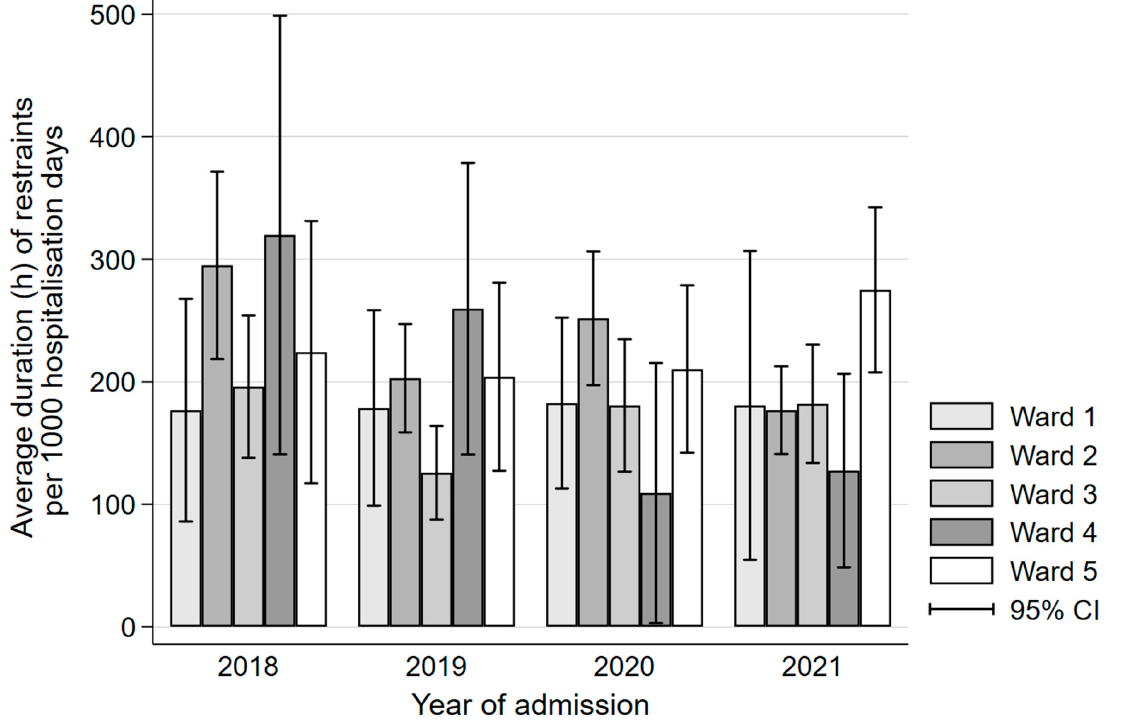
Figure 4. Bar chart of average duration in hours of restraint per year and ward. Legend: CI, confidence interval.